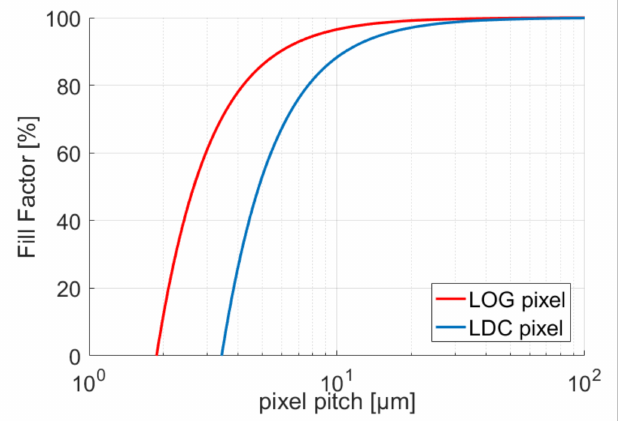
Figure 5. Calculated fill factor in semilogarithmic scale for both the logarithmic pixel (in red) and the proposed low dark current pixel (in